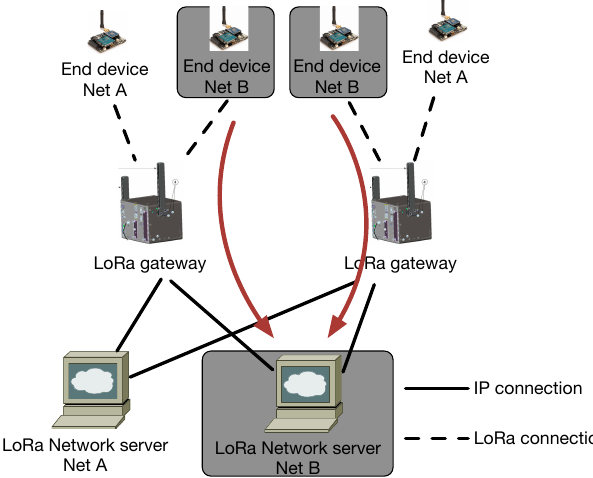
Figure 12. An example of shared gateways in LoRa. The gateways can forward the packet to different network